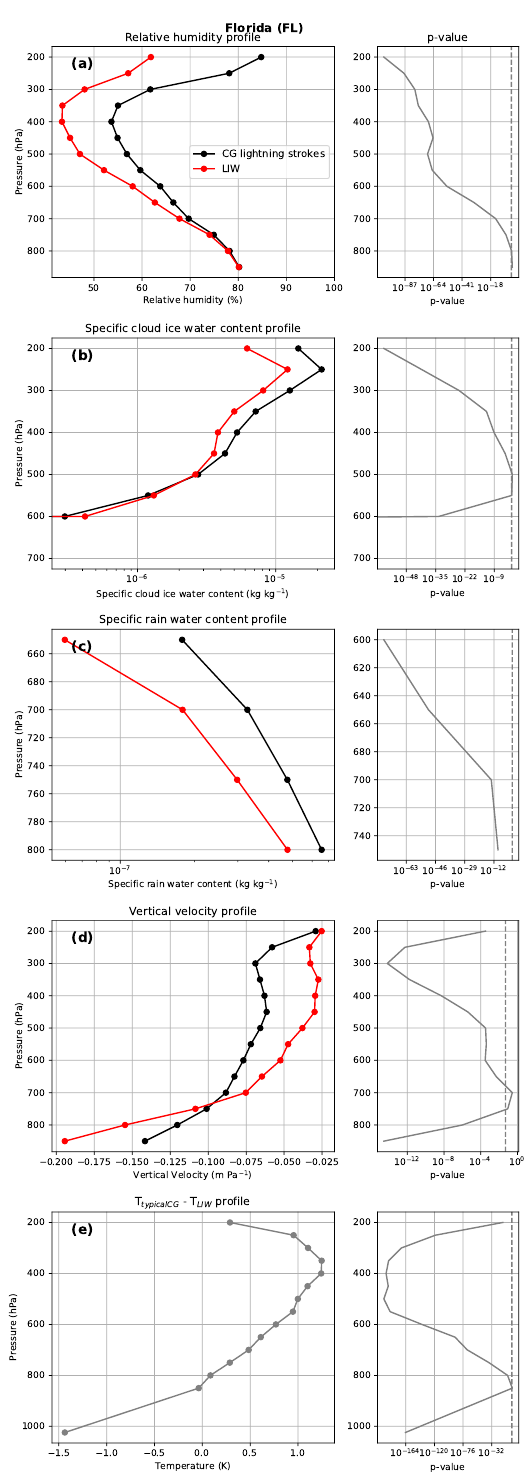
Figure 7. Vertical profiles of the most important meteorological conditions for LIW (red) and typical CG (black) in Florida.The first column shows the vertical profiles of the median relative humidity ( a ), specific cloud ice water content ( b ), specific rain water content ( c ), vertical velocity ( d ), and temperature difference ( e ) for the CG stroke and LIW climatologies during the fire season in Florida between 2009 and 2013. The second column shows the p -value (solid line) for each vertical level, representing the probability of equal medians for both distributions (the dashed line shows the significance limit at 0.05). The p -values were obtained from the Kruskal–Wallis H-tests